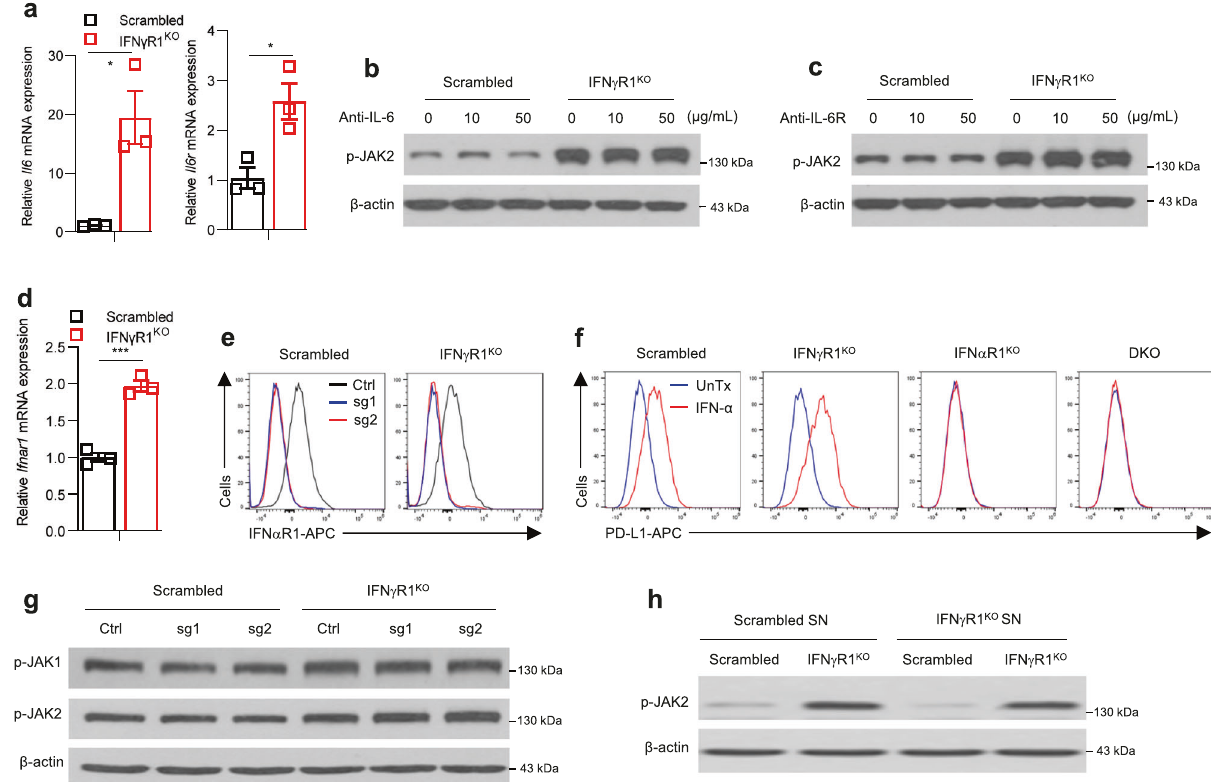
e – g Scrambled and IFN γ R1 KO cells were transduced with different sgRNAs against mouse Ifnar1 .SuccessfullytransducedcellswereanalyzedforIFN α R1expressionin untreatedcells( e )andPD-L1expressionafterstimulationwith100ng/mLIFN- α for 48h ( f ) by fl ow cytometry (FACS strategy 1) and p-JAK1/2 in untreated cells by WB ( g ). h p-JAK2 in scrambled and IFN γ R1 KO cells incubated with supernatants (SN) harvested from scrambled or IFN γ R1 KO cultures for 24h, analyzed by WB. β -actin was used as a loading control in WB. All the experiments were repeated twice with similar results. A two-sided Student ’ s t -test was used for statistical analyses in a , d . Source data are provided in the Source Data fi